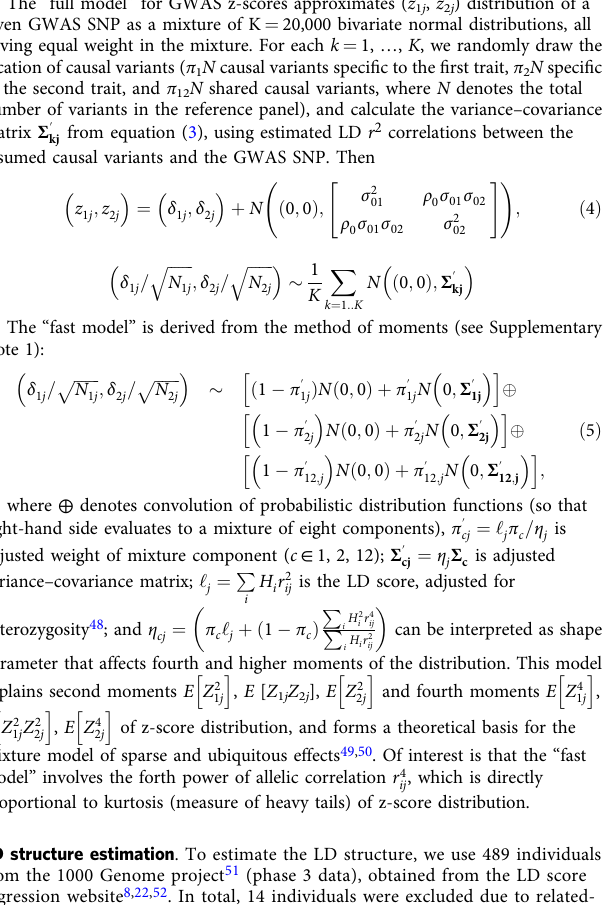
For traits with K-fold difference in polygenicity ( π u 1 ¼ K π u 2 ), the formula predicts an upper bound on genome-wide genetic correlation: r g (cid:6) ρ 12 = equality holds if causal variants of the less polygenic trait form a subset of the higher-polygenic trait. Quantile – quantile plots . Univariate Q – Q plots and strati fi ed Q – Q plots for the model were constructed from pdf j ( z ) density as de fi ned by Eq. (3), given fi tted parameters of the model and LD structure of j-th SNP, calculated across a fi ne grid of z-scores ranging from 0 to 38 with 0.05 step. We average pdf j ( z ) across 1% of randomly sampled SNPs, and numerically integrate the resulting probability density function to convert it into a cumulated distribution function. Error bars on data Q – Q plots represent the 95% binomial con fi dence interval ffiffiffiffiffiffiffiffiffiffiffiffiffiffiffiffiffiffiffiffiffiffiffiffiffiffiffiffi q ±1 : 96 q 1 (cid:2) q ð Þ = n total